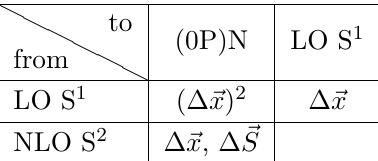
Table 3 . Contributions to the NLO S 2 sectors from position shifts and spin redefinitions in lower- order